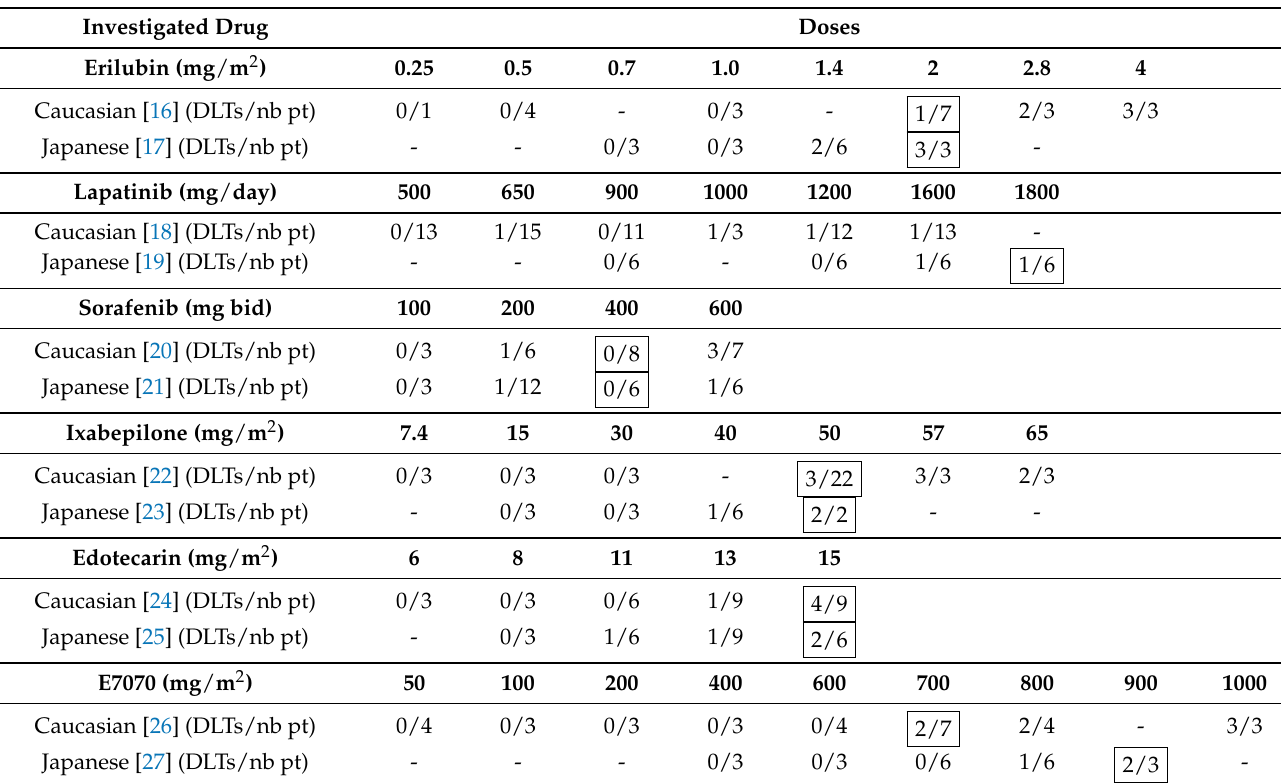
Table 2. Value of dose-limiting toxicity and total number of patients accrued at each dose for all trials analysed in this manuscript. In the first column, the trial population is specified. A dash (-) means that the dose was not tested in the specified population. A box denotes the dose that has been defined as MTD, if the MTD was reached in the trial. For Sorafenib, the doses were given twice daily